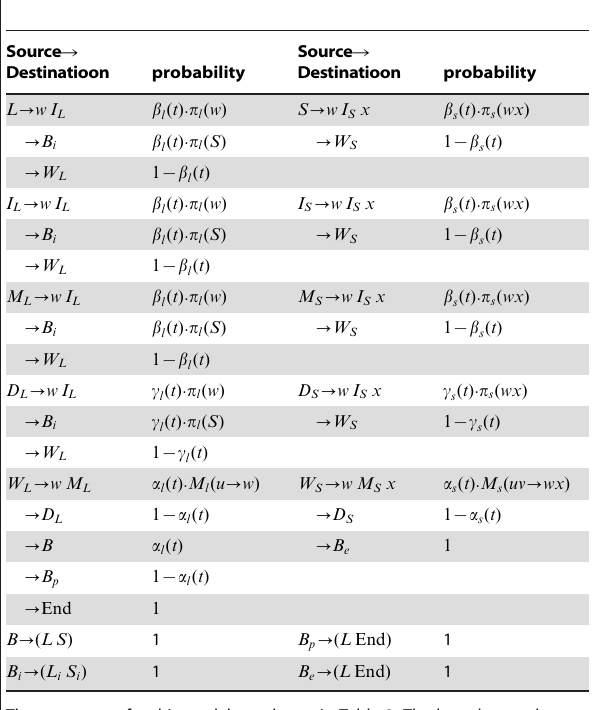
Table 4. Branch transducer (conditionally-normalized Pair SCFG) of the TKF Structure Tree model.